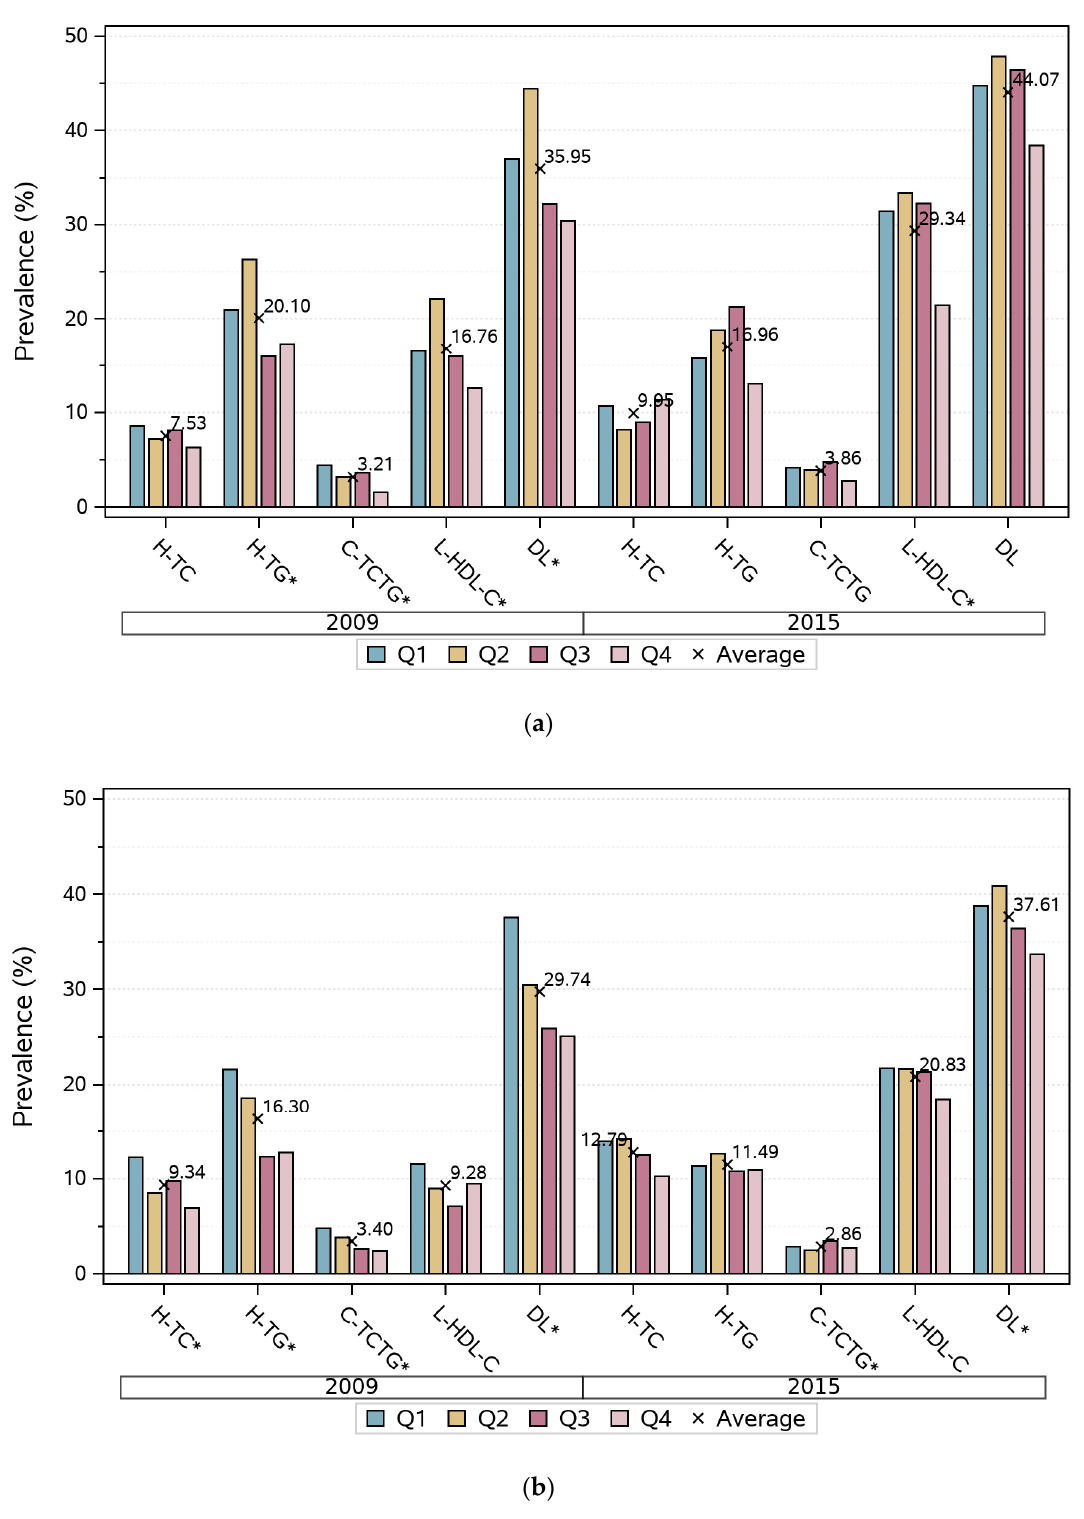
Figure 3. Prevalence of dyslipidemia by quartiles of total physical activity among Chinese adults from nine provinces in 2009 and 2015. H-TC, hypercholesterolemia; H-TG, hypertriglyceridemia; L-HDL-C, low high-density lipoprotein cholesterol; C-TCTG, combined hyperlipidemia; DL, dyslipidemia. Q = quartile. The cross and the number adjacent are the average prevalence of this variable. ( a ) Male; ( b ) Female. Chi-square trend test, * p < 0.05.